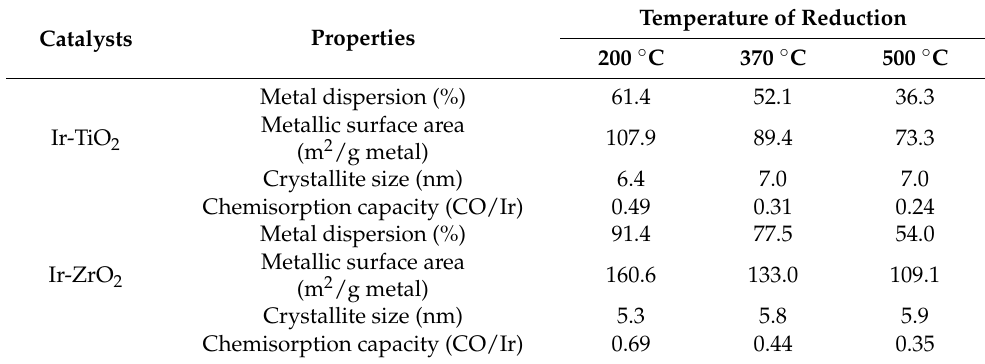
Table 3. CO chemisorption data of the Ir-TiO 2 and Ir-ZrO 2 catalysts.